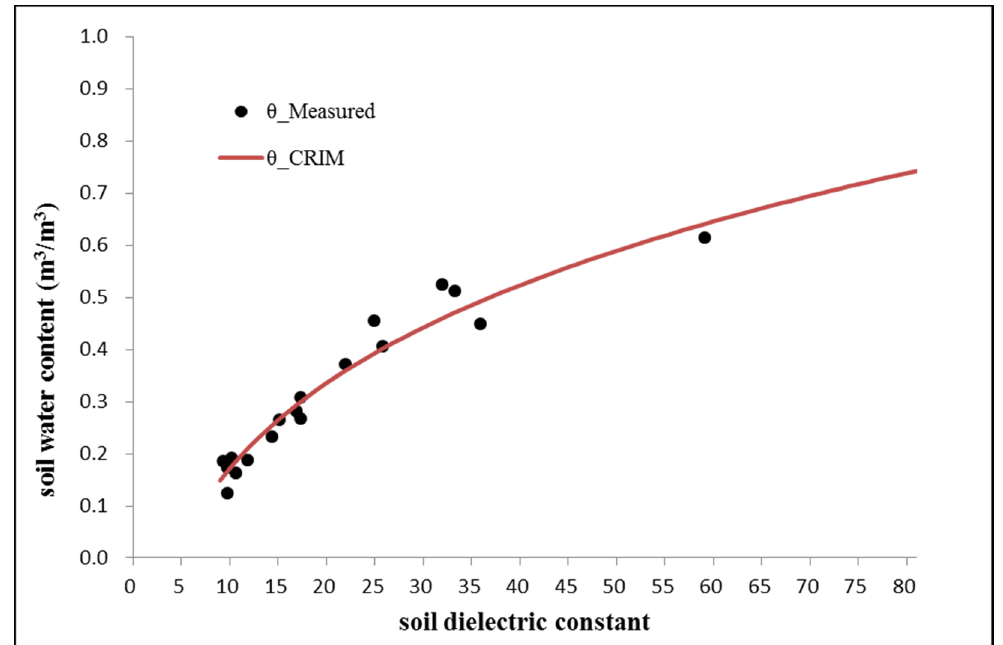
Figure 8. Comparison of CRIM against with measured soil moisture.